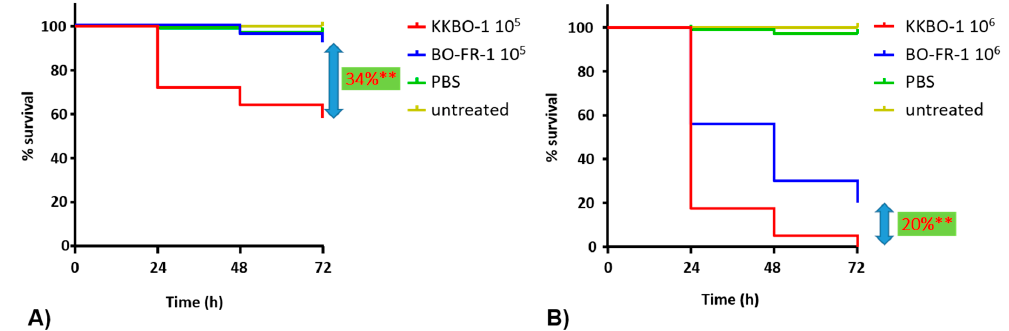
Figure 3. Kaplan–Meier survival curves of Galleria mellonella larvae. Infections have been performed with 10 5 ( A ) or 10 6 ( B ) cells of KKBO-1 or BO-FR-1. Data are the means of five independent experimental replicates. ** indicates p < 0.0001.